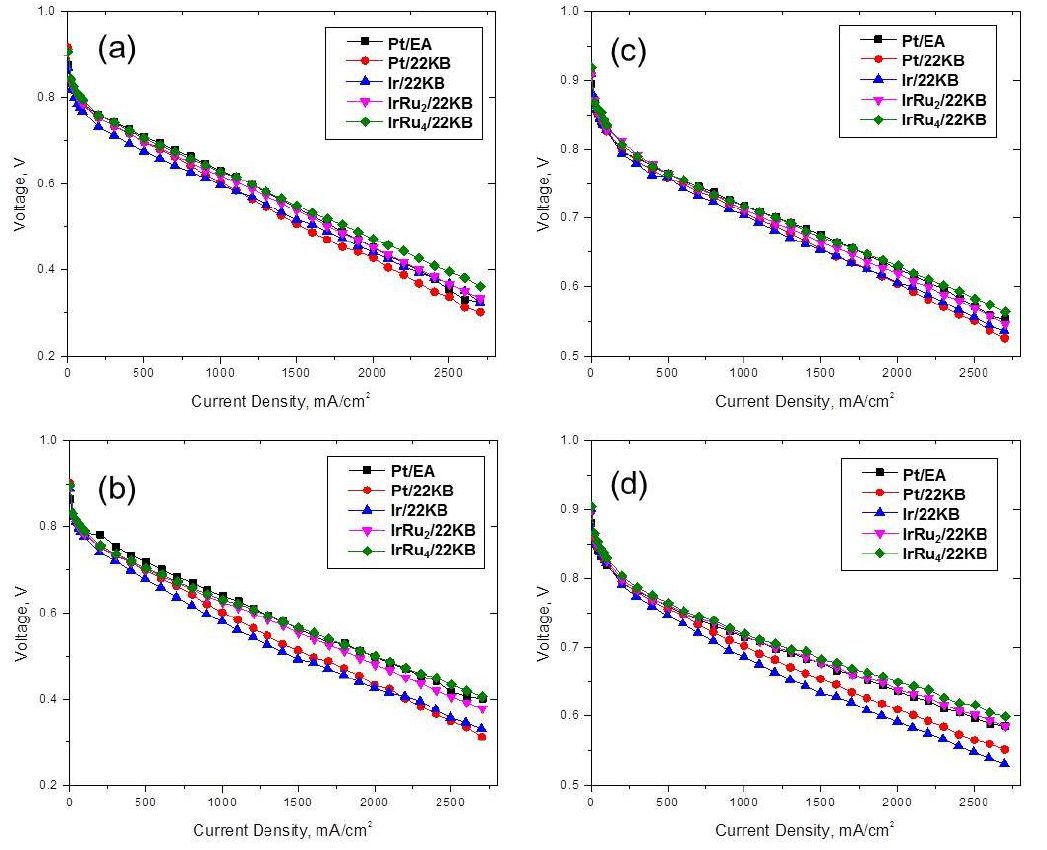
Figure 2. Polarization curves of polymer electrolyte membrane fuel cells (PEMFCs) with membrane electrode assemblies (MEAs) prepared from various anode catalysts (Pt/EA, Pt/22 KB, Ir/22 KB, IrRu 2 /22 KB and IrRu 4 /22 KB) at ( a ) 65 °C, 50% RH, ambient pressure; ( b ) 65 °C, 100% RH, ambient pressure; ( c ) 90 °C, 50% RH, 150 kPa; ( d ) 90 °C, 100% RH, 150 kPa.